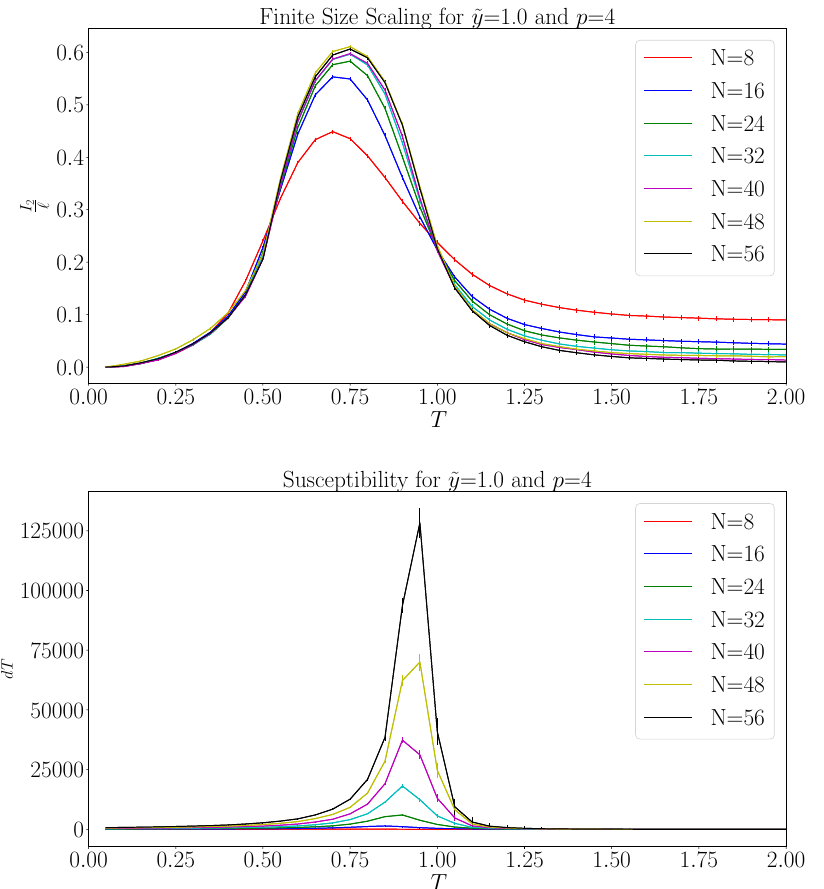
Figure 10 . Top panel: the (cid:12)nite size scaling for RMI of (4.26) with p = 4 and ~ y = 1. This case corresponds to QCD(adj). The curves cross at T and T c , respectively. Bottom panel: the magnetic susceptibility of the system. The susceptibility peaks at T = 1, in agreement with RMI. (cid:24)